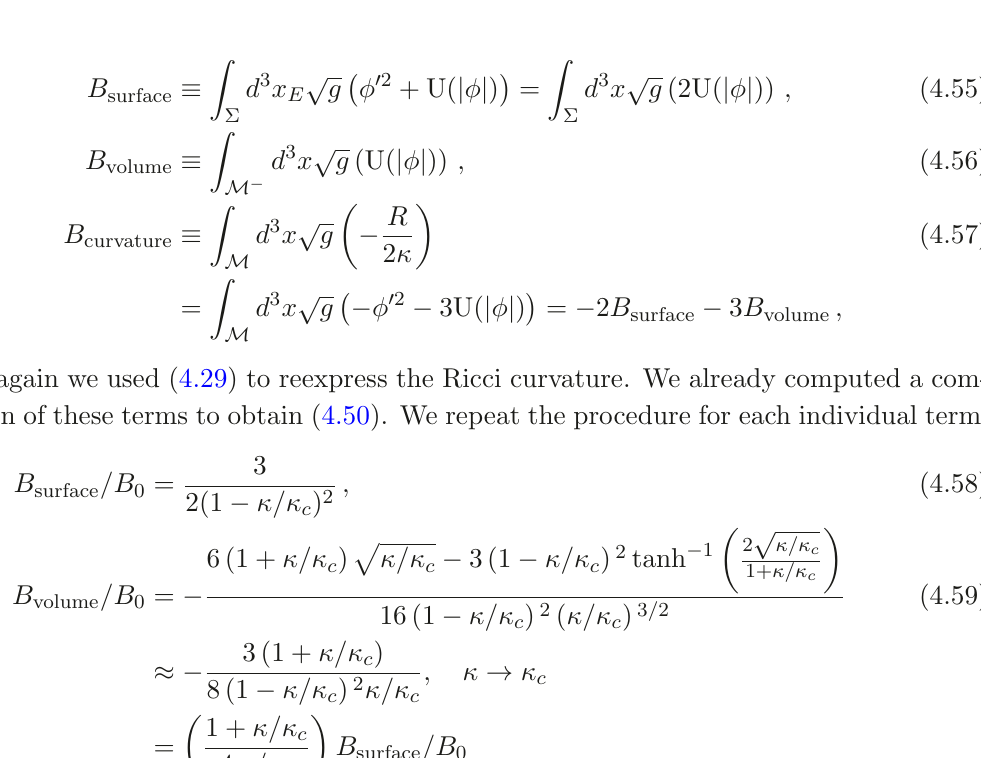
Figure 7. Full line: analytical approximation of B vort /B 0 as a function of κ/κ c , (4.50). Circles: numerical solution with Q m = 0 (Φ = 100 and ǫ = 0 . 6